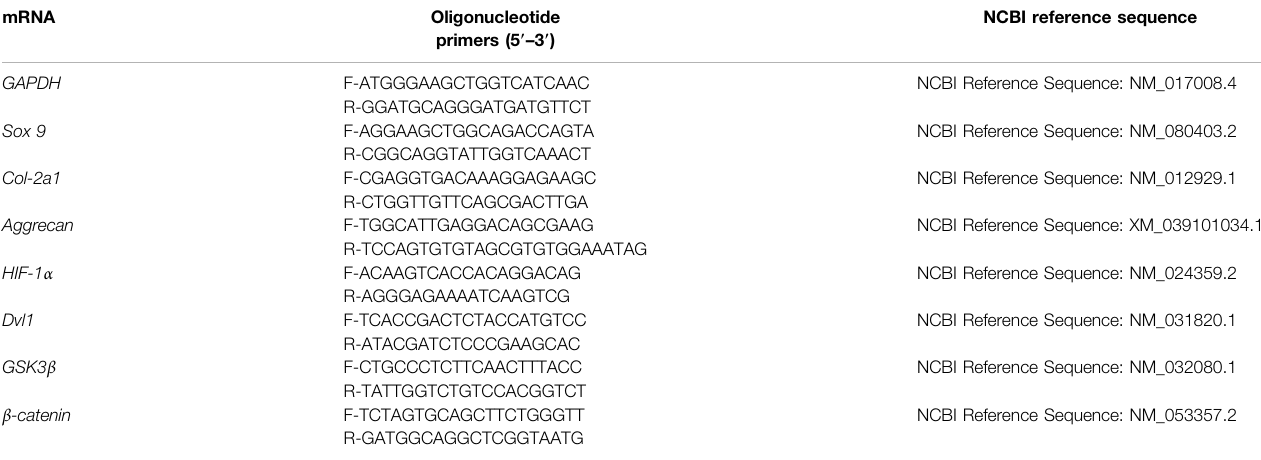
TABLE 1 | Primer sequences of